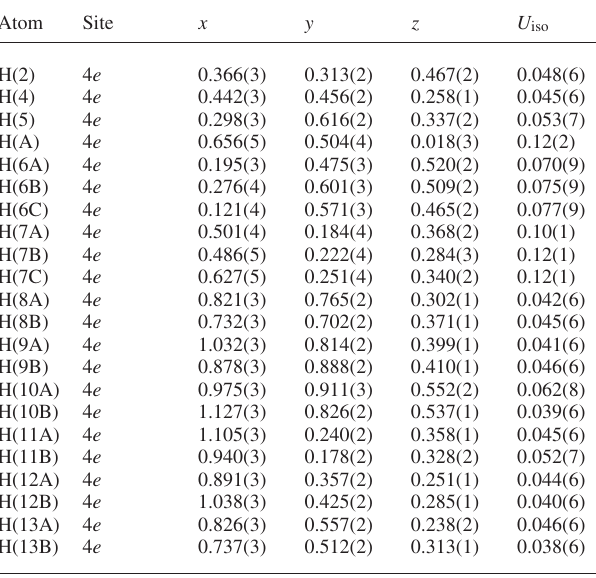
Table 2. Atomic coordinates and displacement parameters (in Å 2 )